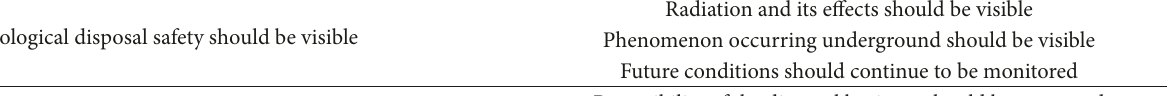
Table 1: Requirements on a repository identified by a “voice of the market” survey of Japanese stakeholders (e.g., from [15]). Geological disposal safety should be